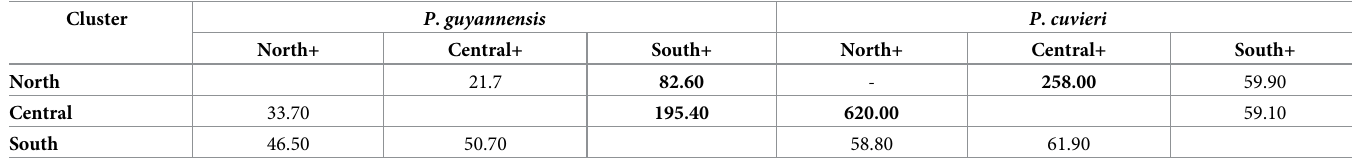
Table 3. Estimated migration among Proechimys guyannensis and P . cuvieri populations, based on analysis using the Migrate software. The samples were divided into three regions, the North (from the Oiapoque River to Guyana), Central (Araguari basin in Amapa´) and South (Amazon Estuary, Jari and Para´ rivers). The plus sign (+) after the name of the region indicates a population receiving immigrants. The highest migration rates are marked in bold type. Cluster